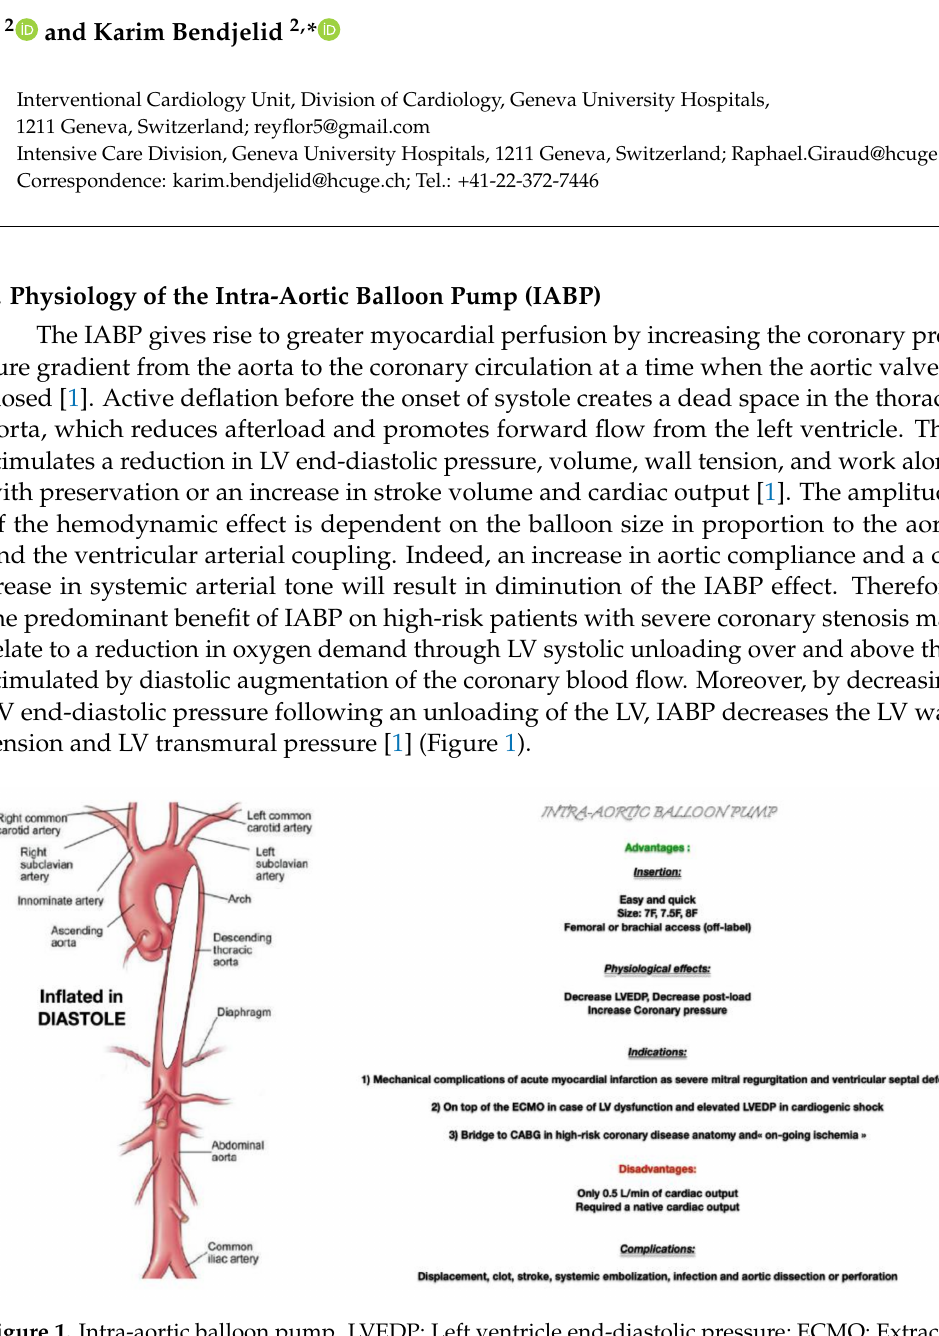
Figure 1. Intra-aortic balloon pump. LVEDP: Left ventricle end-diastolic pressure; ECMO: Extracor- poreal membrane oxygenation; LV: Left ventricle; CABG: coronary artery bypass